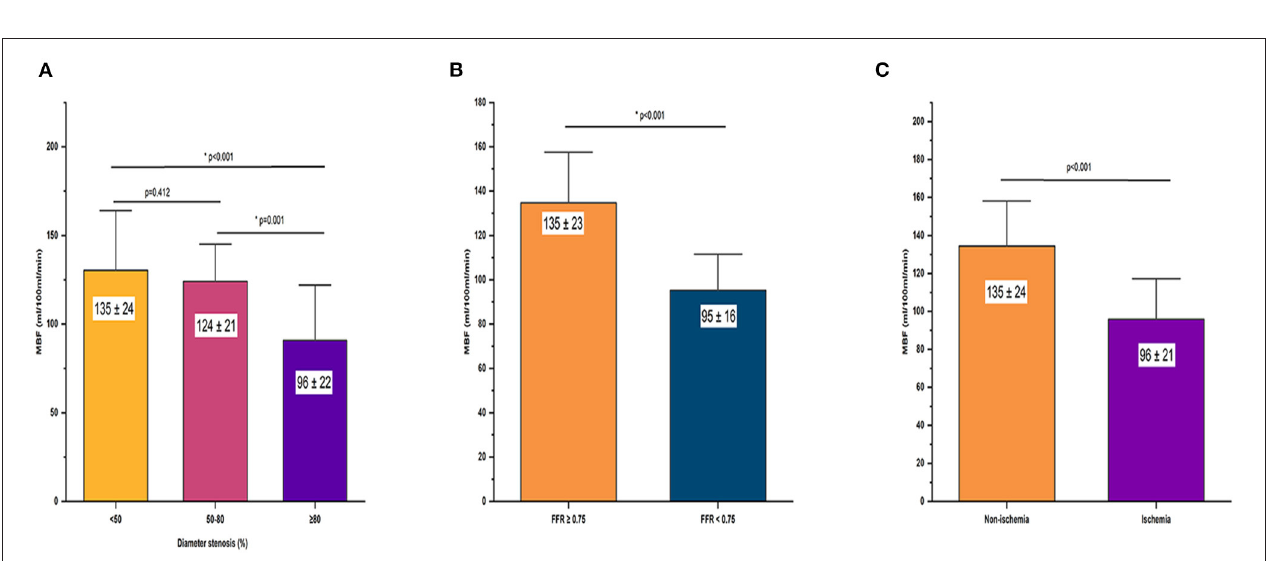
FIGURE 4 | Relationship between hyperemic MBF and severity of stenosis. Bar plots shows (A) hyperemic MBF for vessel territories with server stenosis (DS > 90%) was significantly lower compared with vessel territories without significant stenosis (DS < 30%) and vessel territories with intermediate stenosis (DS 30–90%) at ICA. (B) Hyperemic MBF of non-ischemic myocardium was significantly lower than ischemic myocardium defined by ICA/FFR. (C) Hyperemic MBF was significantly lower in vessels with FFR of ≤ 0.80 compared with that in vessels with FFR > 0.80. DS, diameter stenosis; FFR, fractional flow reserve; ICA, invasive coronary angiography; MBF, myocardial blood